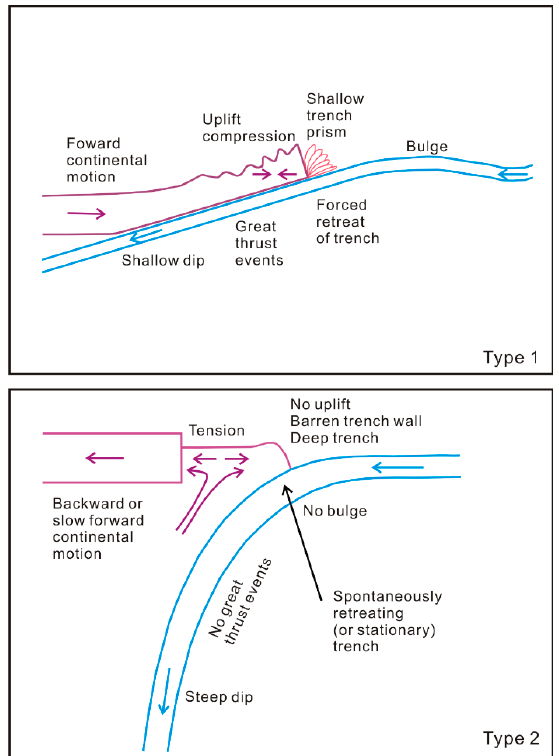
Figure 4. Two types of subduction boundaries related to subduction steepness. Type 1 (“flat-slab subduction”) = compression/thrusting in the back-arc region; type 2 (“steep-slab subduction”) = tension in the back-arc region (modified from Uyeda et al. [39]). During type 1, inversions can be expected in the back-arc basin.